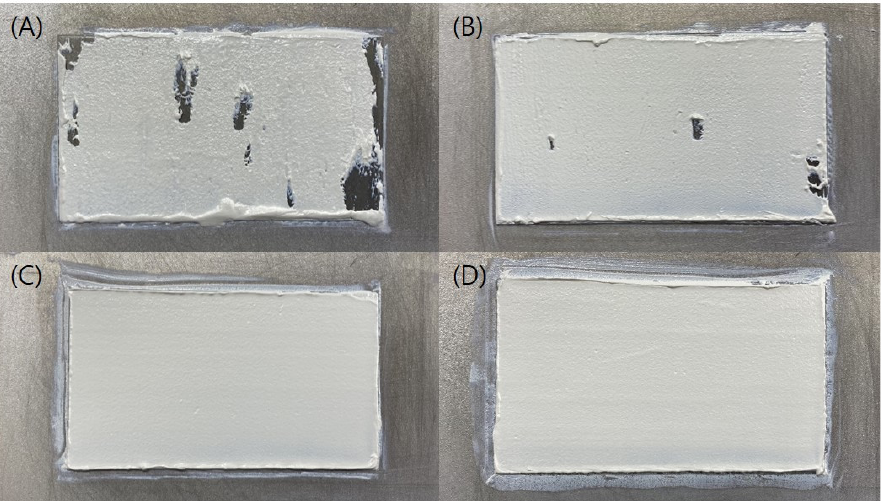
Figure 6. Flatness according to various blade temps: ( A ) 15 °C; ( B ) 40 °C; ( C ) 70 °C; ( D ) 100